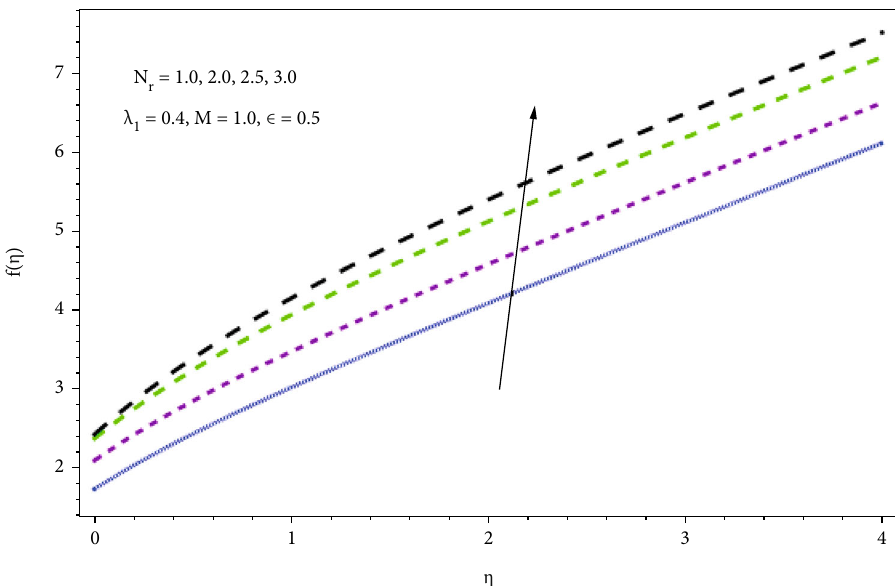
Figure 4: Illustration of the e ff ect of N